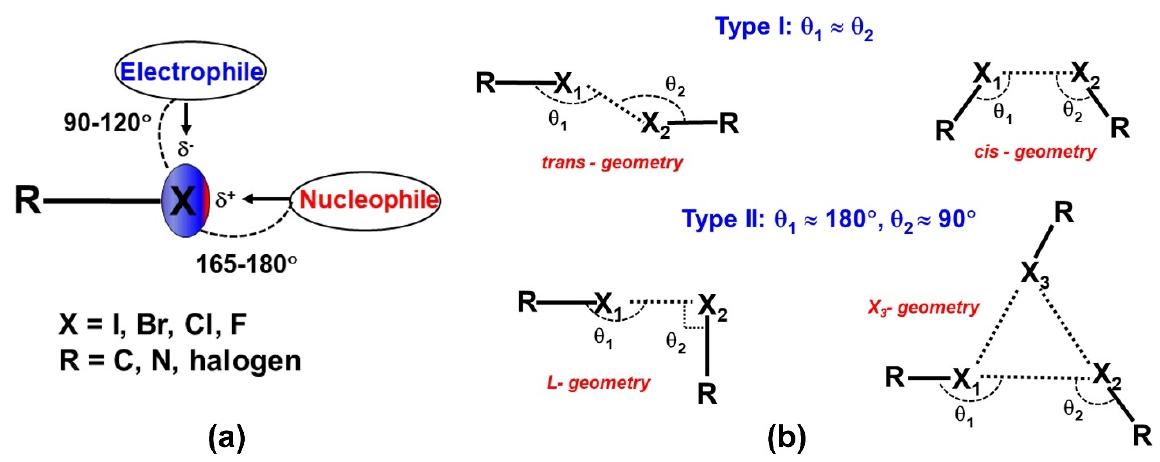
Figure 2. ( a ) Schematic representation of a typical halogen bond ( b ) Schematic representation of different geometries of X ··· X interactions, where X is a halogen.